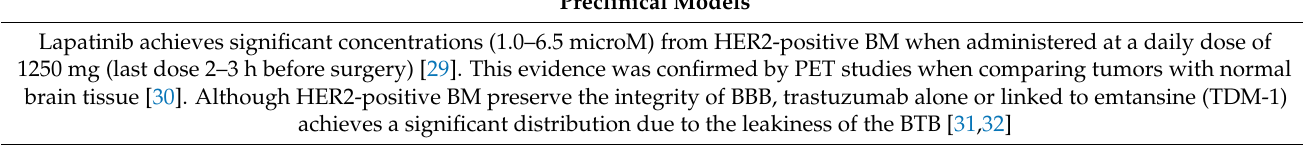
Table 1. Cont . Preclinical